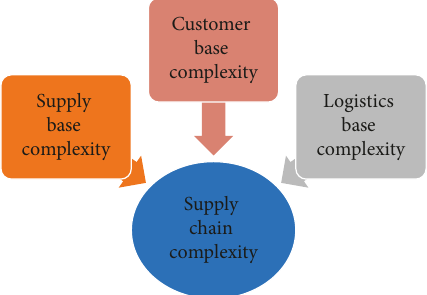
Figure 1: The dimensions of supply network